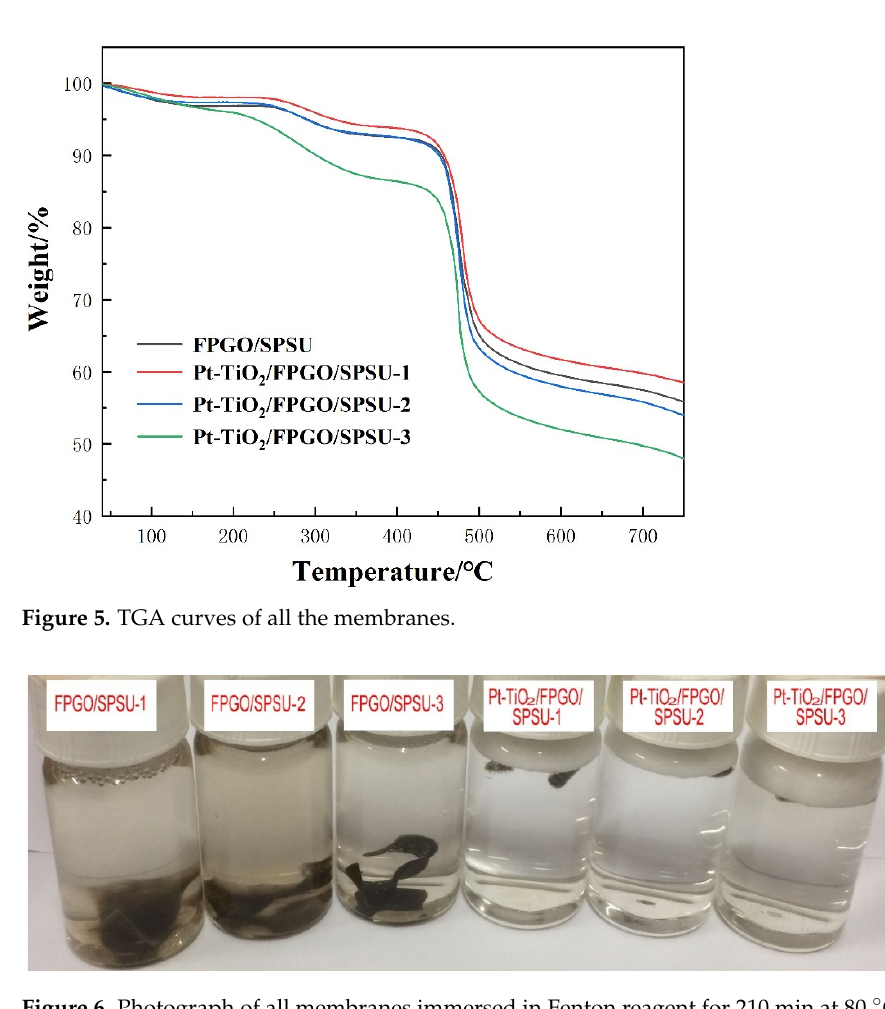
Figure 6. Photograph of all membranes immersed in Fenton reagent for 210 min at 80 °C. Table 2. Oxidative stability of all the